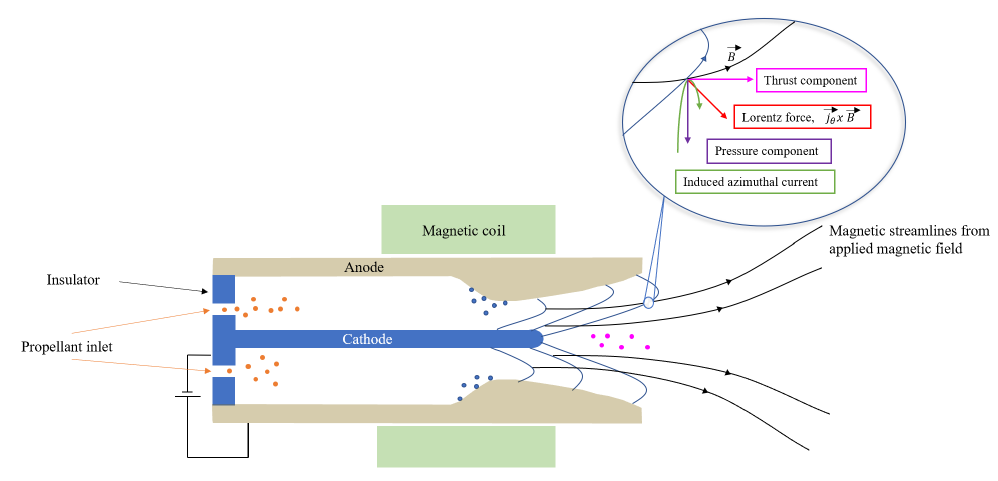
Figure 12. An Applied Field MagnetoPlasmaDynamic Thruster as a simplified schematic